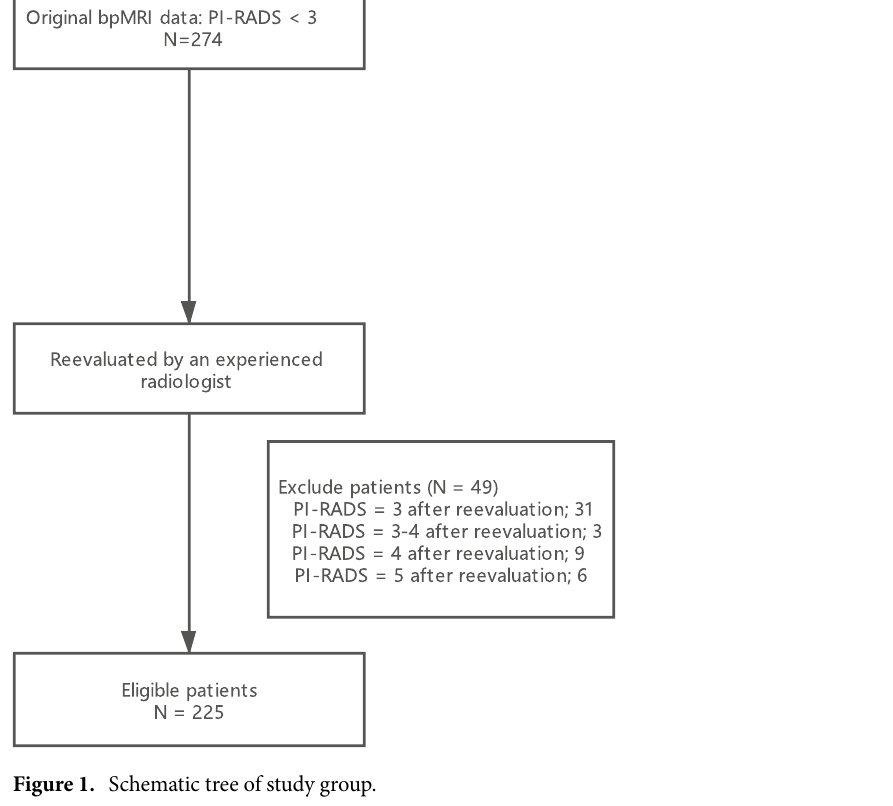
Figure 1. Schematic tree of study